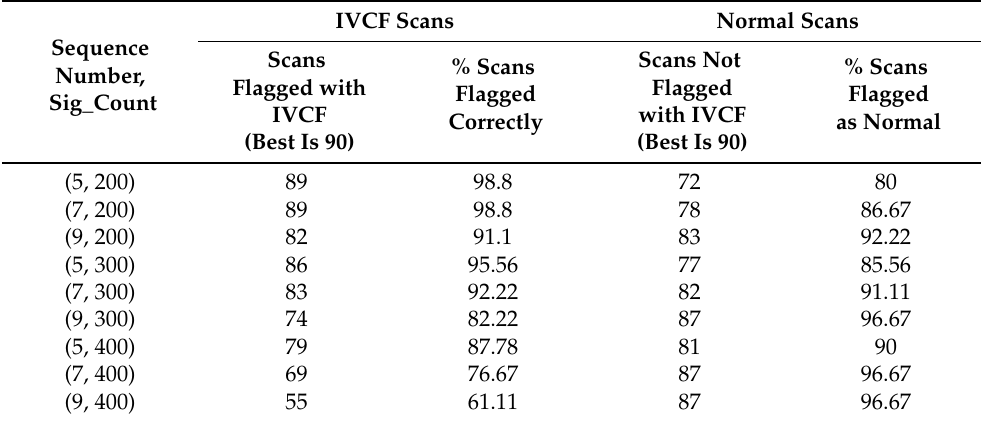
Table A2. Prediction pipeline performance for hard normalized segmentation using a combination of different